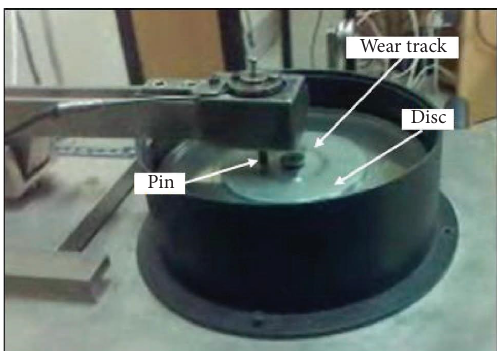
Figure 11: Friction coefcient observation.